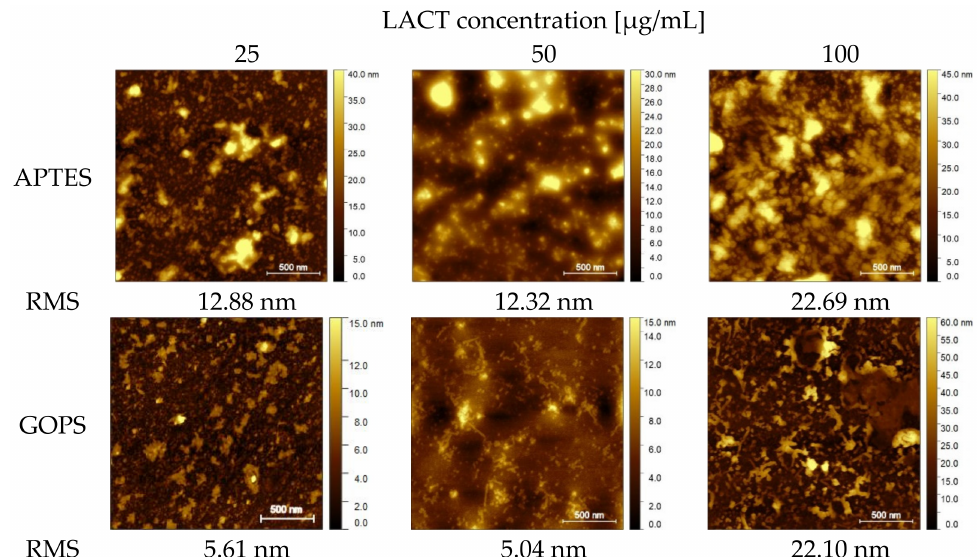
Figure 3. Non-contact AFM images for substrates subjected to silanization with APTES/GA+LACT and GOPS+LACT, on which the protein was applied at specific concentrations. The size of scanning area is 2 × 2 µ m 2 .